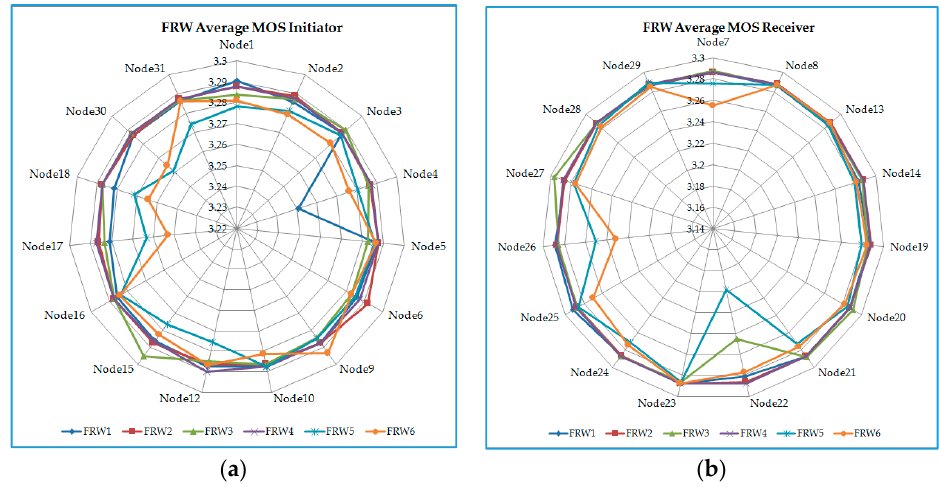
Figure 8. First responders with random waypoint mobility MOS values: ( a ) VoIP initiators; ( b ) VoIP receivers. Information 2017 , 8 , 88